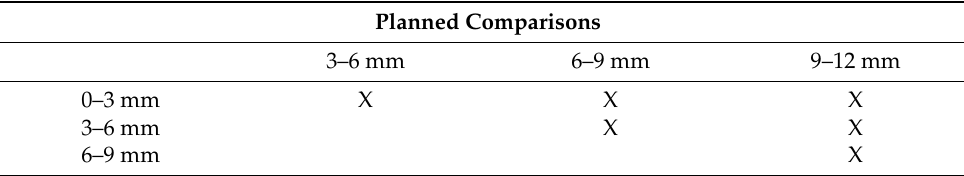
Table A2. An illustration of the six planned comparisons across the perilesional bands. Planned